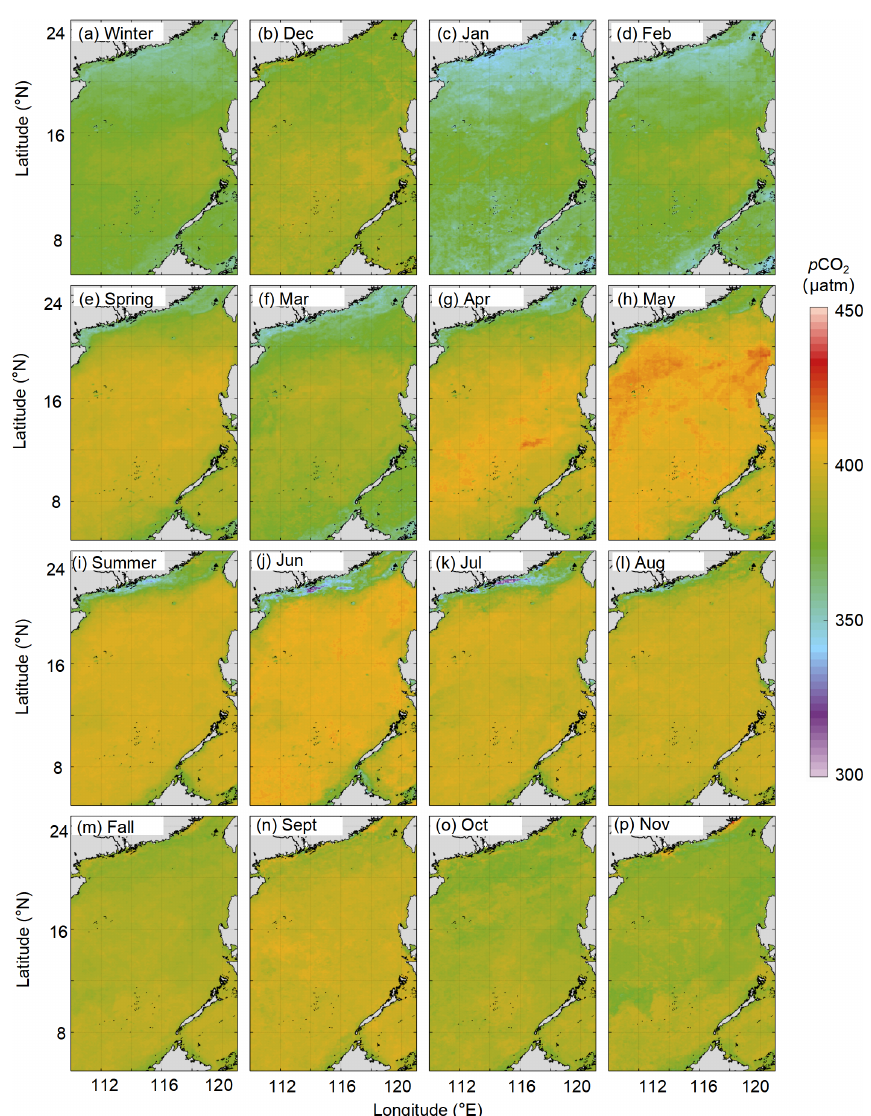
Figure 12. Long-term (2003–2020) seasonal and monthly averaged p CO 2 field (µatm). (a) Winter. (b) December. (c) January. (d) February. (e) Spring. (f) March. (g) April. (h) May. (i) Summer. (j) June. (k) July. (l) August. (m) Fall. (n) September. (o) October. (p) November. Table 4. Deseasonalized long-term trend of the spatially averaged monthly p CO 2 data for each subregion of the South China Sea (µatmyr − 1 ).